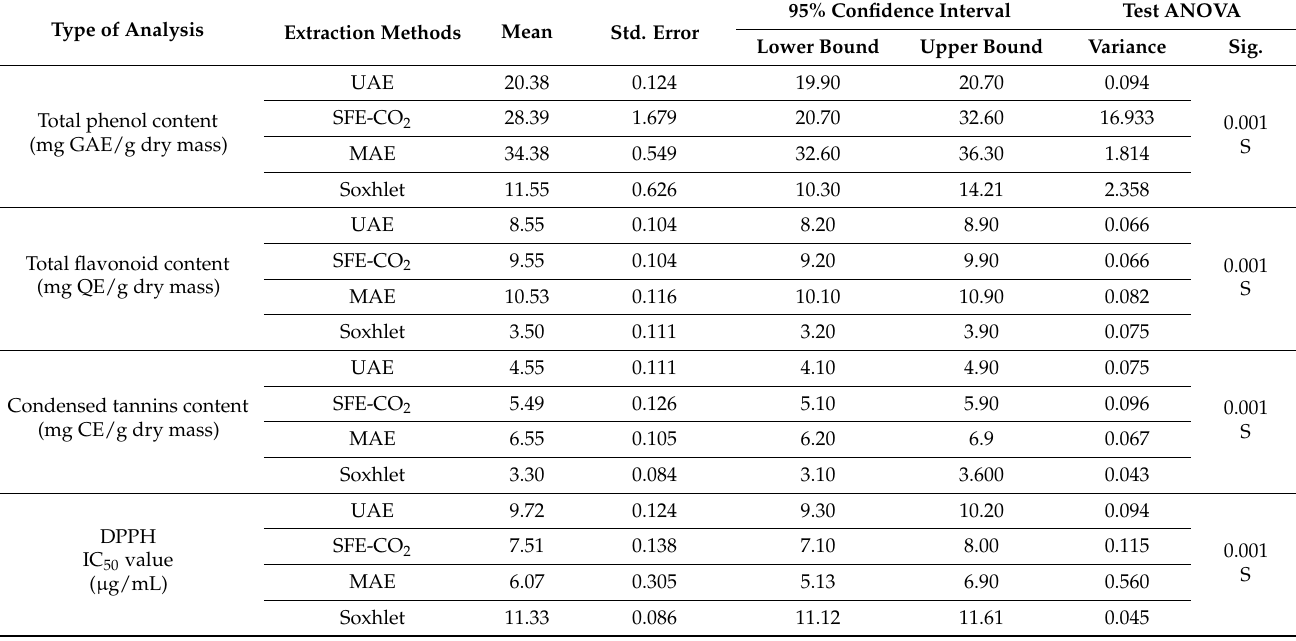
Table 3. Statistical analysis of the means performed by one-way analysis of variance